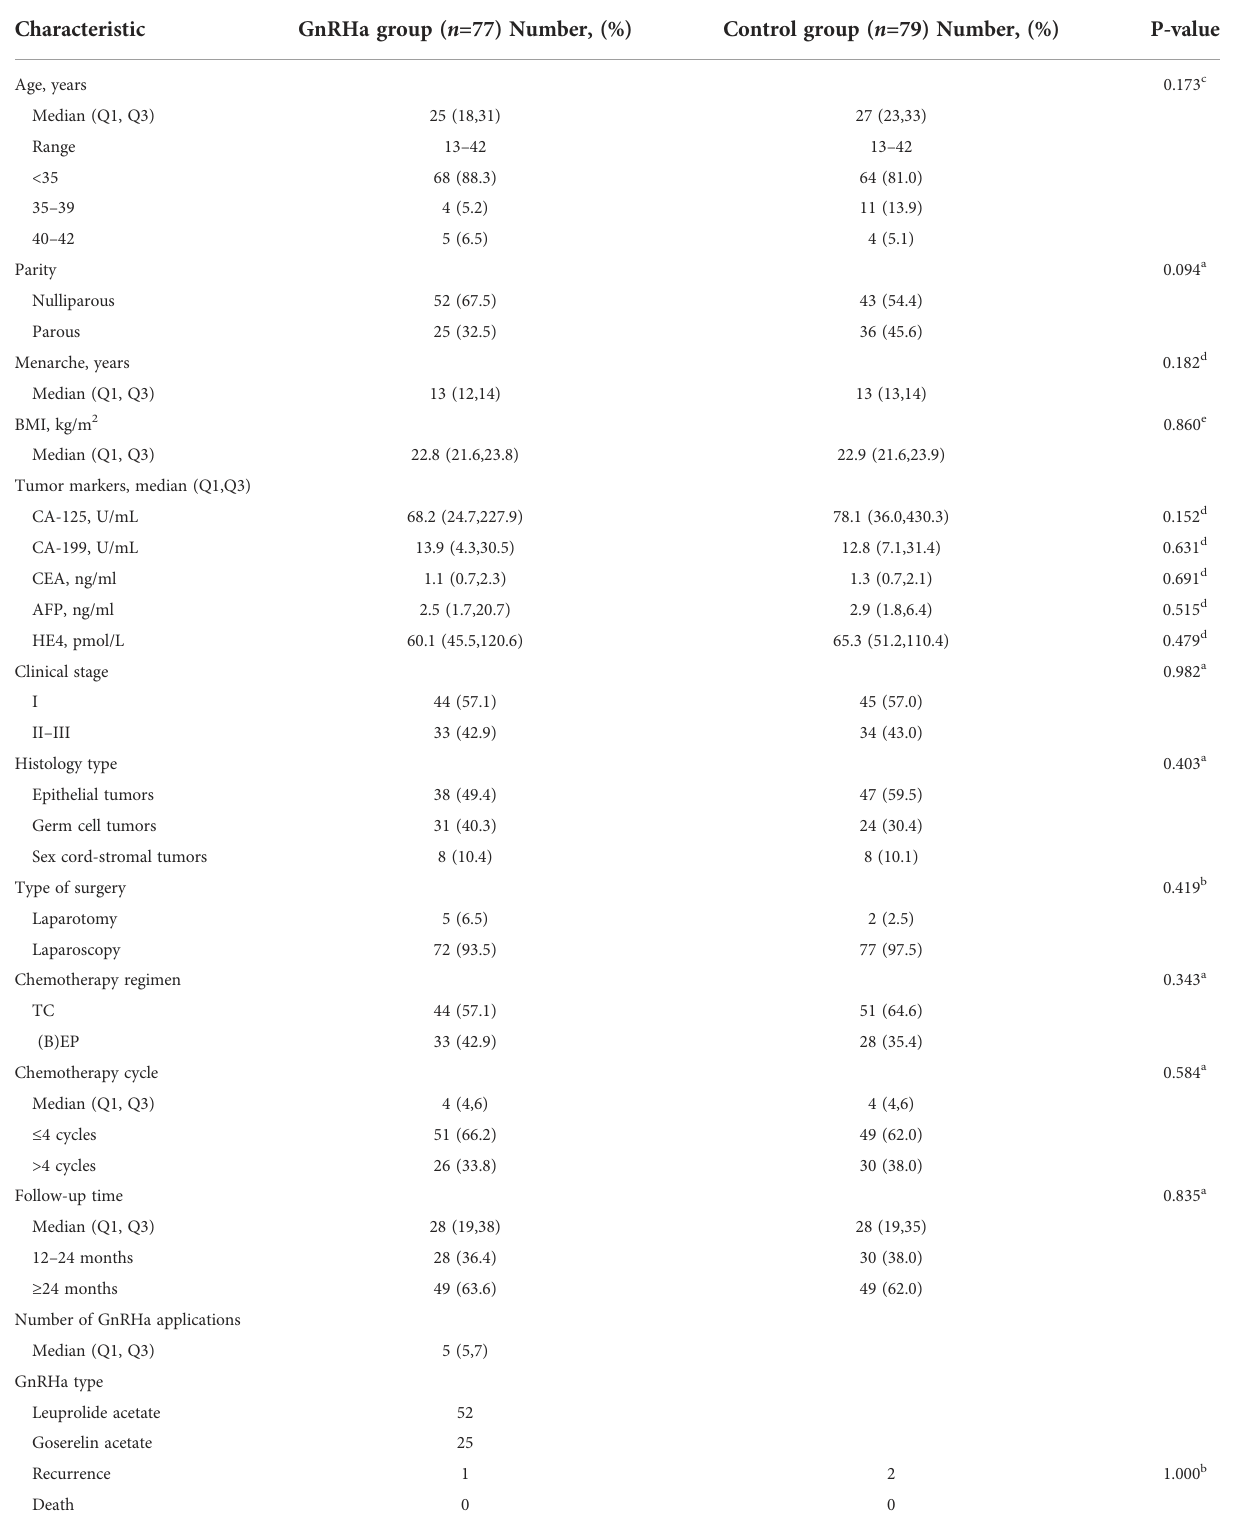
TABLE 1 Patient clinical